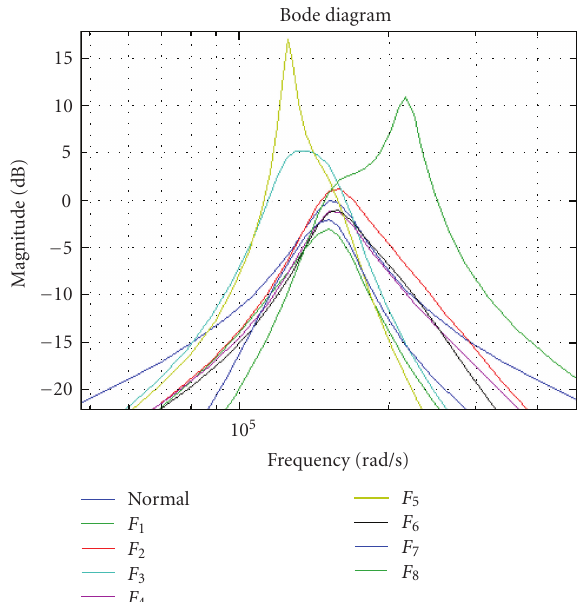
Figure 5: Response of the single components faults at the output